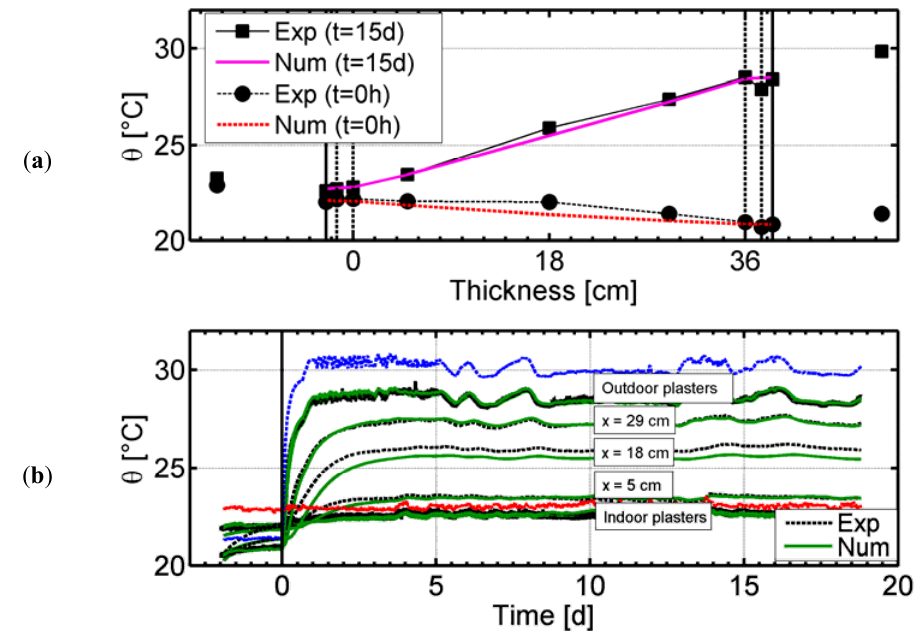
Figure 14. Comparison between experimental (black lines) and simulated (colored lines) temperature of coated hemp concrete wall subjected to temperature and relative humidity gradient. ( a ) Top graph shows the spatial response at t = 0 and 15 d; ( b ) bottom graph the transient response at x = 5, 18 and 29